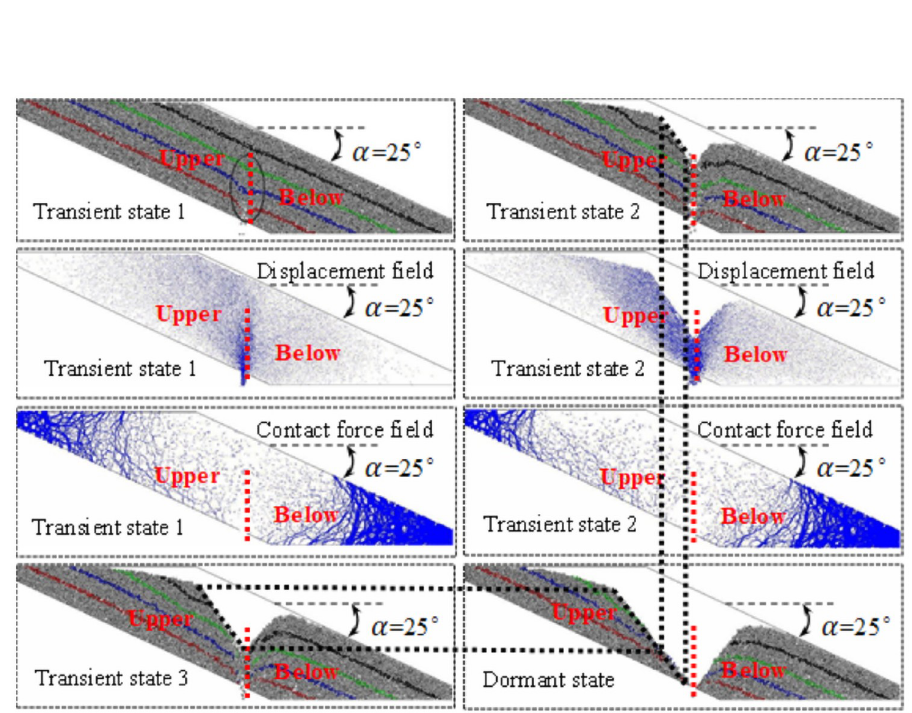
Fig 10. Falling form, displacement field and contact force field of transportation roadway.